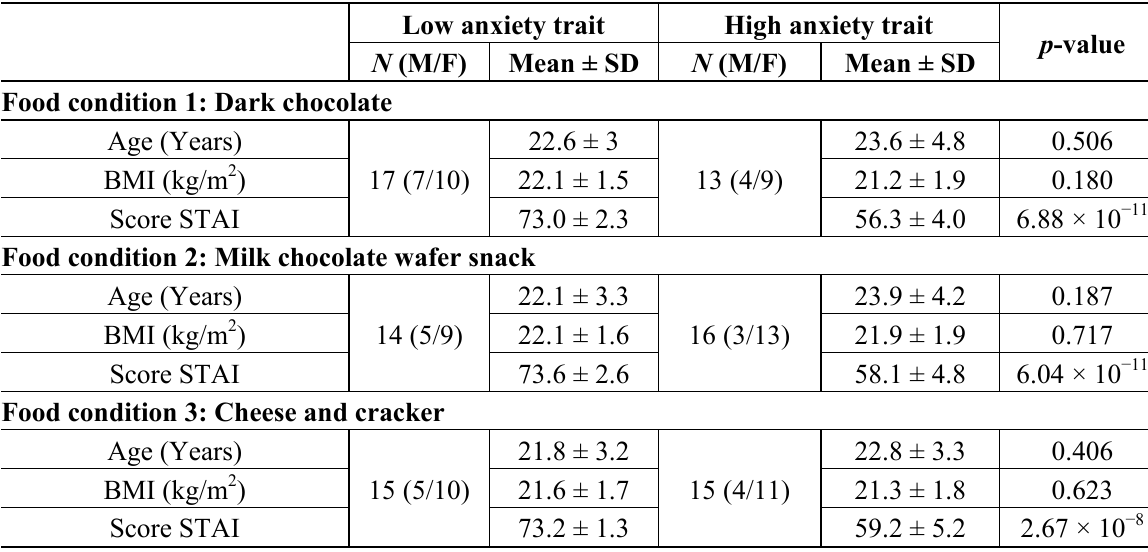
Table 2. Demographic data.